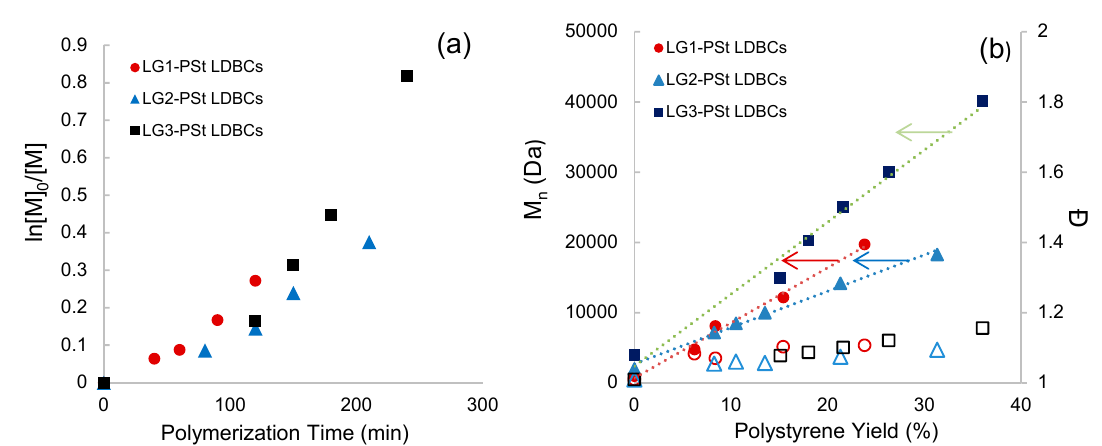
Figure 1. ( a ) Kinetic plots of dendron-initiated ATRP; ( b ) dependence of molecular mass, M n (solid symbols), and polydispersity, PDI (hollow symbols), on PSt yield. ATRP conditions: all polymerizations were performed in bulk at 95 ◦ C; [LG1-i]:[St]:[CuBr]:[PMDTEA] = 1:300:2:2; [LG2-i]:[St]: